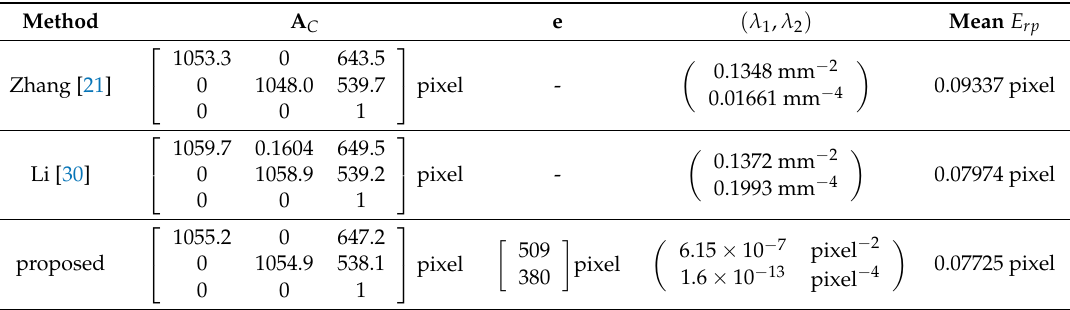
Table 4. System parameters of simulation.